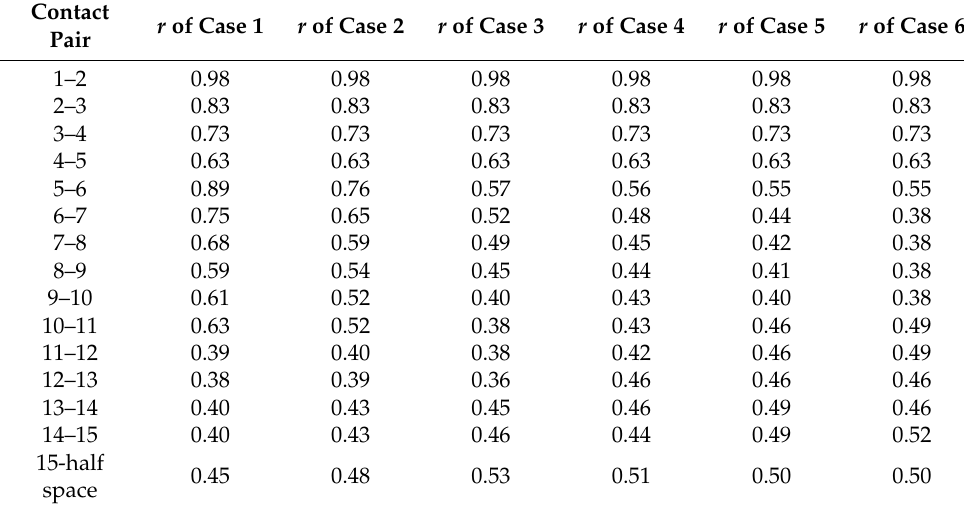
Table 3. The maximum contact radius r for all cases